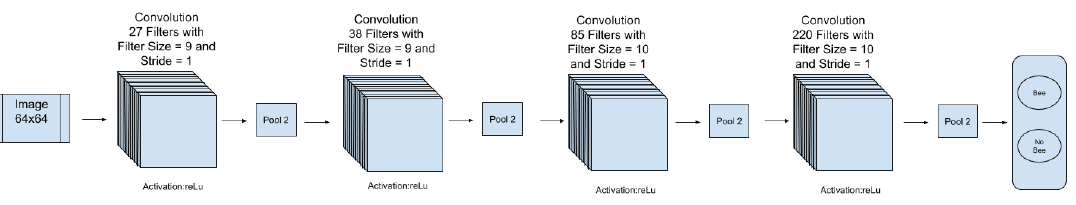
Figure A1. The architecture of ConvNetGS-3, the best performing auto-designed ConvNet on BEE1.